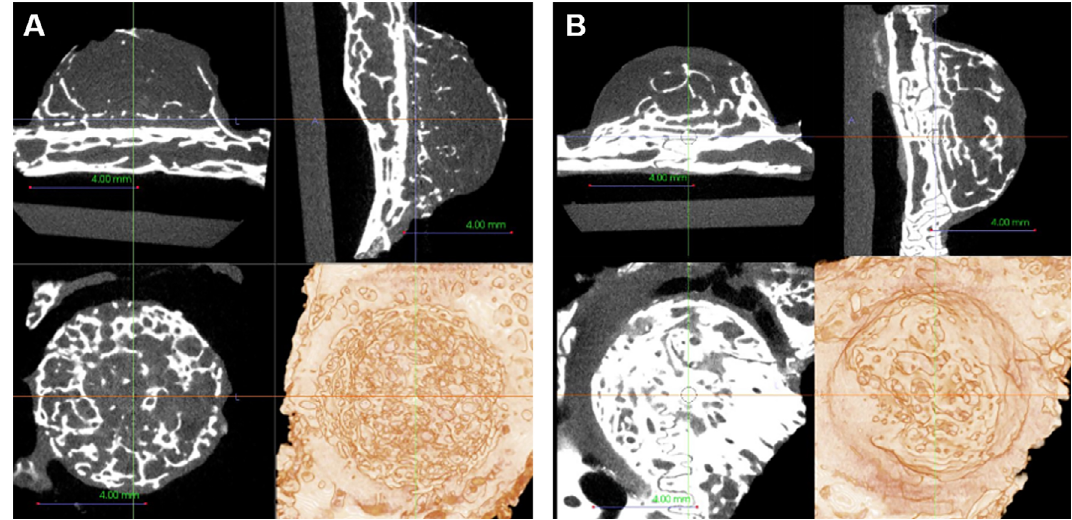
Figure 4- Cross-sectional and 3D rendering of micro-CT images of a specimen at week 6